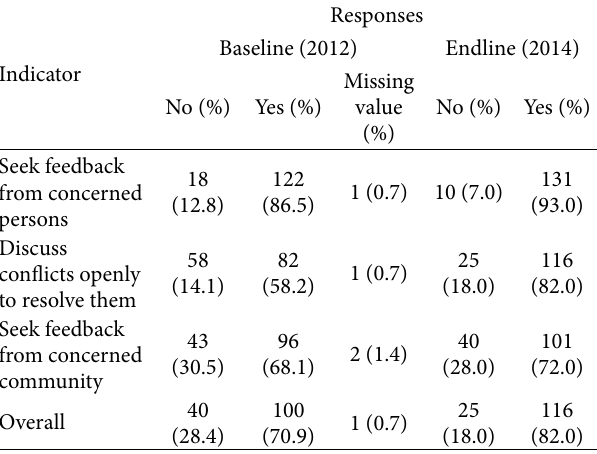
Table 2: Promotion of use of RHIS information.